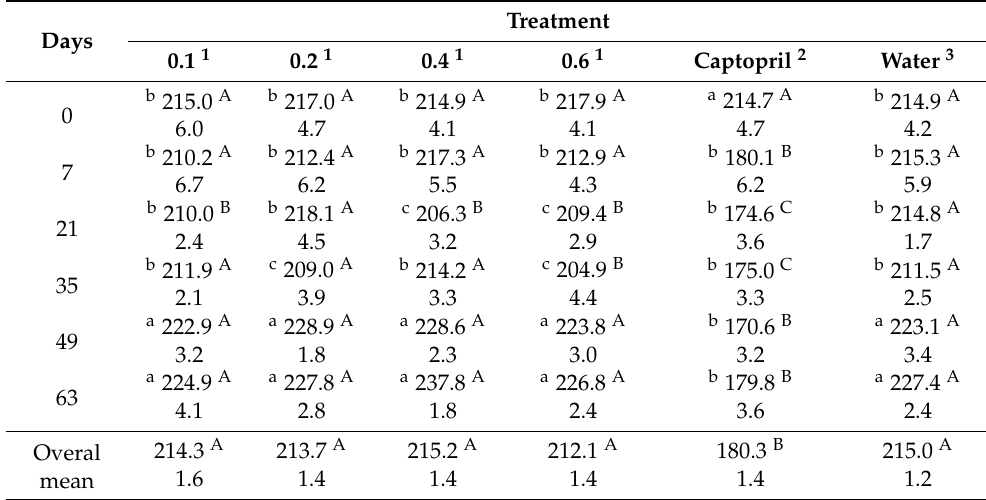
Table 5. LsMean and SEM of systolic blood pressure in different groups of SHRs.